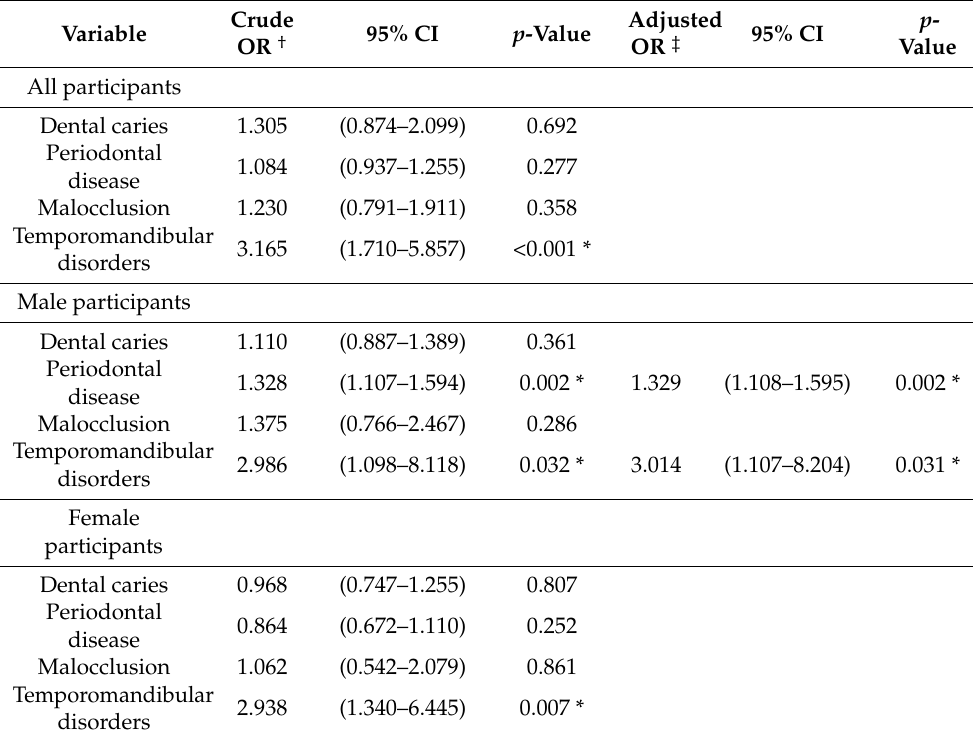
Table 3. Crude and adjusted odds ratios and 95% confidence intervals of the variables associated with having >30 UPI